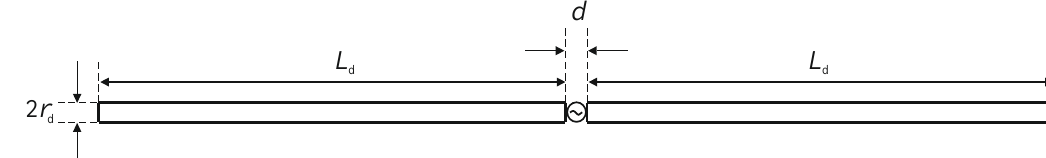
( b ) Figure 13. The electric field derived from the 1-GHz half-wave dipole antenna with a shortening ratio set at k s = 0.67: ( a ) near field distribution; ( b ) far field radiation. In the popular FEM- and FDTD-based engines, the dipole antenna is modelled as a two-armed metal antenna with a perfect electric conductor (PEC). Thus, the zero value of the tangent component of the electric field strength ( E x = 0) is assumed on the surface of each dipole arm. Generally, a symmetrical transmission line with characteristic impedance of 50 Ω supplies a dipole antenna. For numerical calculation purposes, modeling of the feeding coaxial cable is omitted. It is sufficient that each dipole is fed by a point-dipole sinusoidal voltage source with an internal load of 50 Ω, located between the dipole arms. In the FDTD-based software Sim4Life [36], this was modelled using the